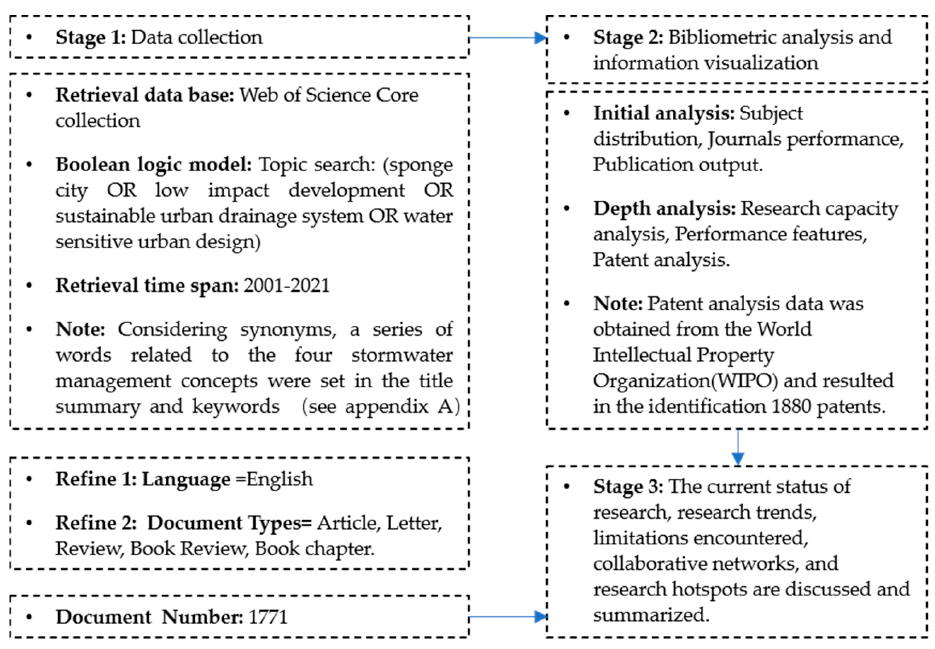
Figure 1. Stages of the bibliometric analysis of urban runoff management (Appendix A).